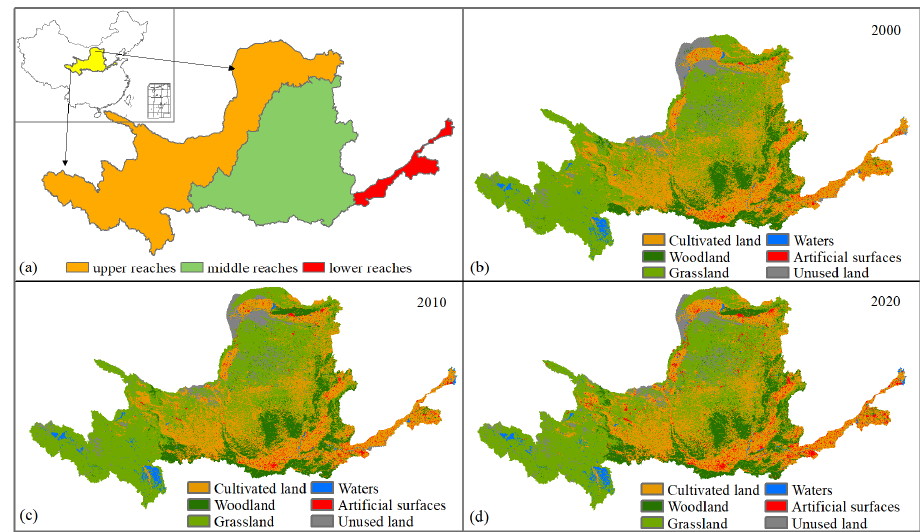
Figure 1. The location of Yellow River Basin (YRB) ( a ), land use and land cover (LULC) patterns in 2000 ( b ), 2010 ( c ), and 2020 ( d ).